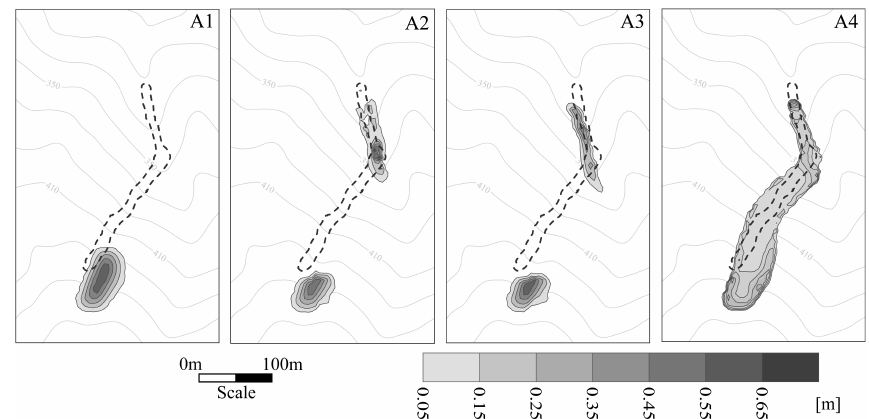
Fig. 8. Distressed hillside – Filled depth contours of sliding debris assuming a volume of 1000m 3 and the rheological parameters calibrated through the back-analysis of the August 2005 debris flow. The dotted line indicates the extent of the August 2005 debris flow (propaga- tion+deposit). (A1) Triggering area, (A2) Frictional rheology, (A3) Voellmy rheology, (A4) Quadratic